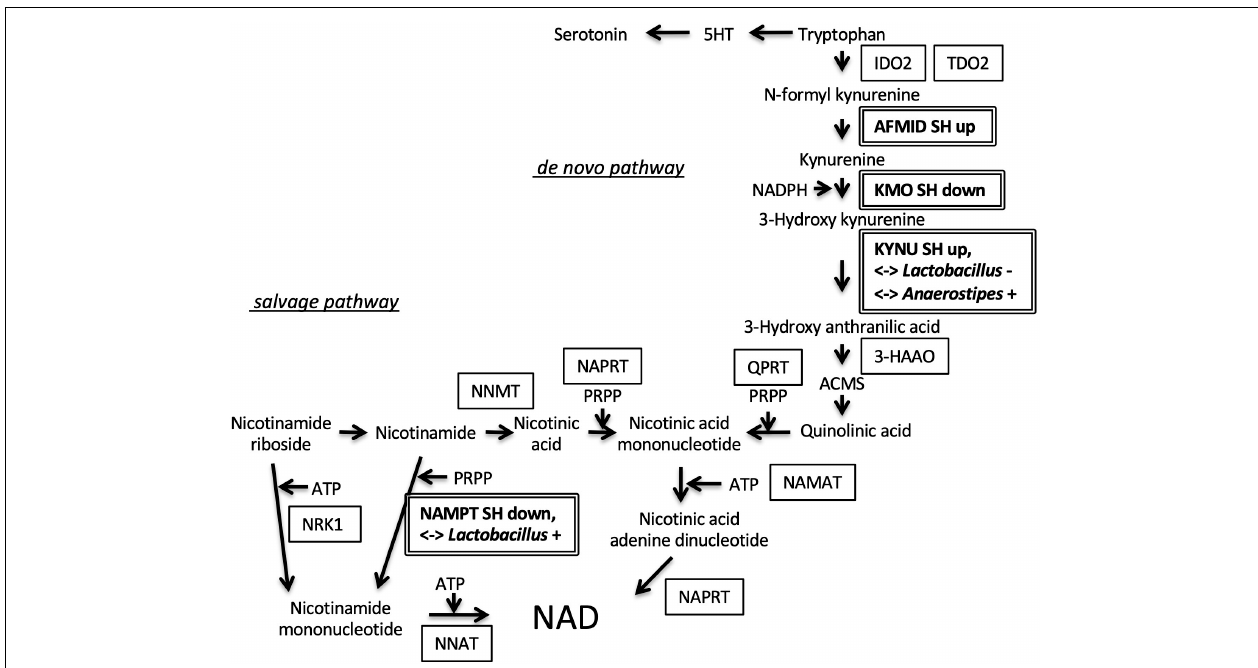
FIGURE 5 | Regulation of genes involved in nicotinamide adenine dinucleotide (NAD) synthesis. Arylformamidase (AFMID) gene upregulated in SH condition and kynurenine 3-monooxygenase (KMO) gene downregulated in SH condition were located at the second, and third step of de novo nicotinamide NAD synthesis from tryptophan, respectively. The fourth enzyme, kynureninase (KYNU) gene was upregulated in SH condition and correlated with the occupancies of two bacteria genera ( Lactobacillus and Anaerostipes ). Nicotinamide phosphoribosyltransferase (NAMPT) gene was downregulated in SH condition and positively correlated with Lactobacillus occupancy. SH up, upregulated in SH condition; SH down, downregulated in SH condition; < – > Lactobacillus + or –, positively or negatively correlated with Lactobacillus ; < – > Anaerostipes +, positively correlated with Anaerostipes ; indoleamine 2, 3-dioxygenase 2, IDO2; tryptophan 2, 3-dioxygenase, TDO2; 3-hydroxyanthranilic acid 3, 4-dioxygenase, 3-HAAO; 2-amino-3-carboxymuconate-6-semialdehyde, ACMS; quinolinate phosphoribosyltransferase, QPRT; nicotinic acid mononucleotide adenylyl transferase, NAMAT; nicotinate phosphoribosyltransferase, NAPRT; nicotinamide N-methyltransferase, NNMT; nicotinamide riboside kinase 1, NRK1; nicotinamide nucleotide adenylyltransferase 1, NNAT; 5-phospho-D-ribose 1-diphosphate,